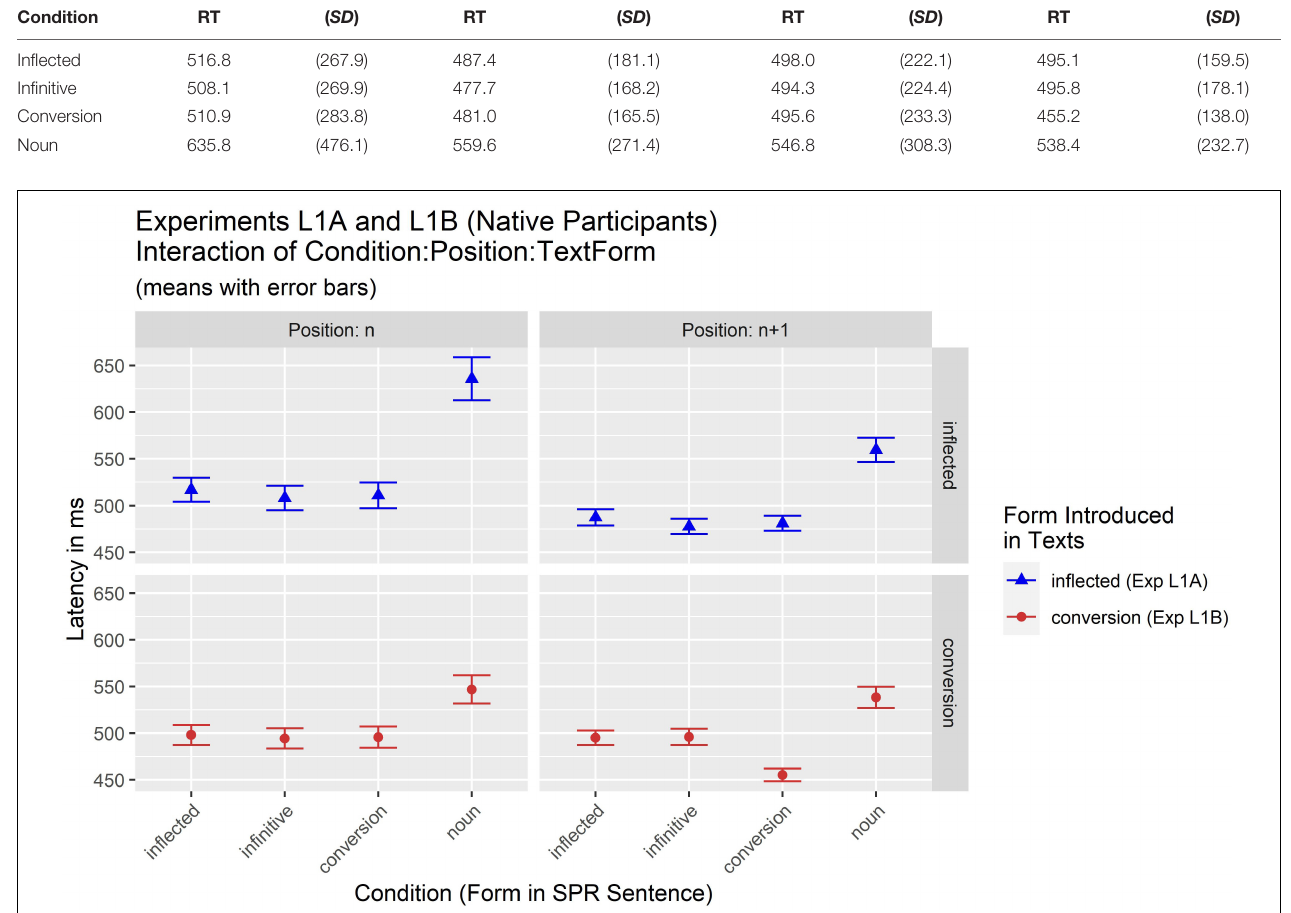
FIGURE 1 | Results of Experiments L1A and L1B: native participants. (Mean latencies of critical regions in SPR